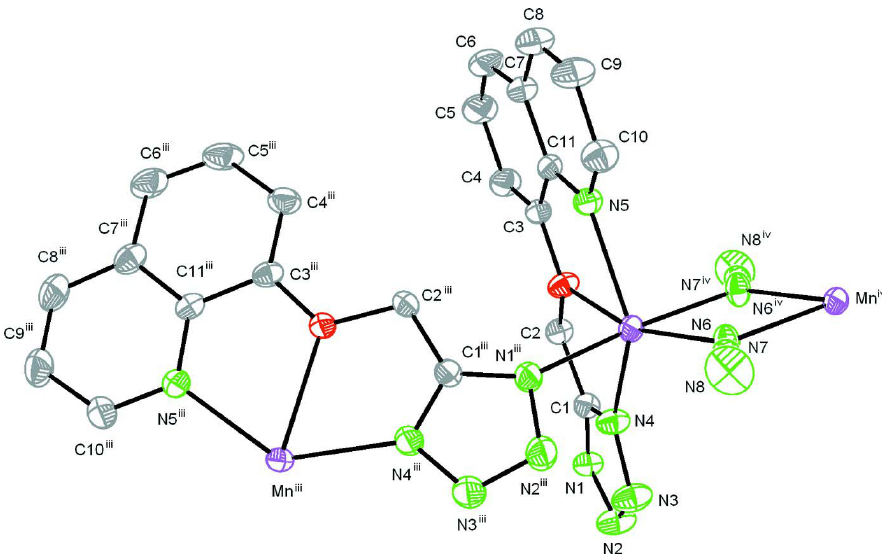
Figure 1 The fragment structure of I showing the atom numbering scheme. Displacement ellipsoids are drawn at the 30% probability level. The hydrogen atoms are presented as small spheres of arbitrary radius. Symmetry codes: (iii) 1- x , 2- y , - z ; (iv) x , 3/2- y , 1/2+ z